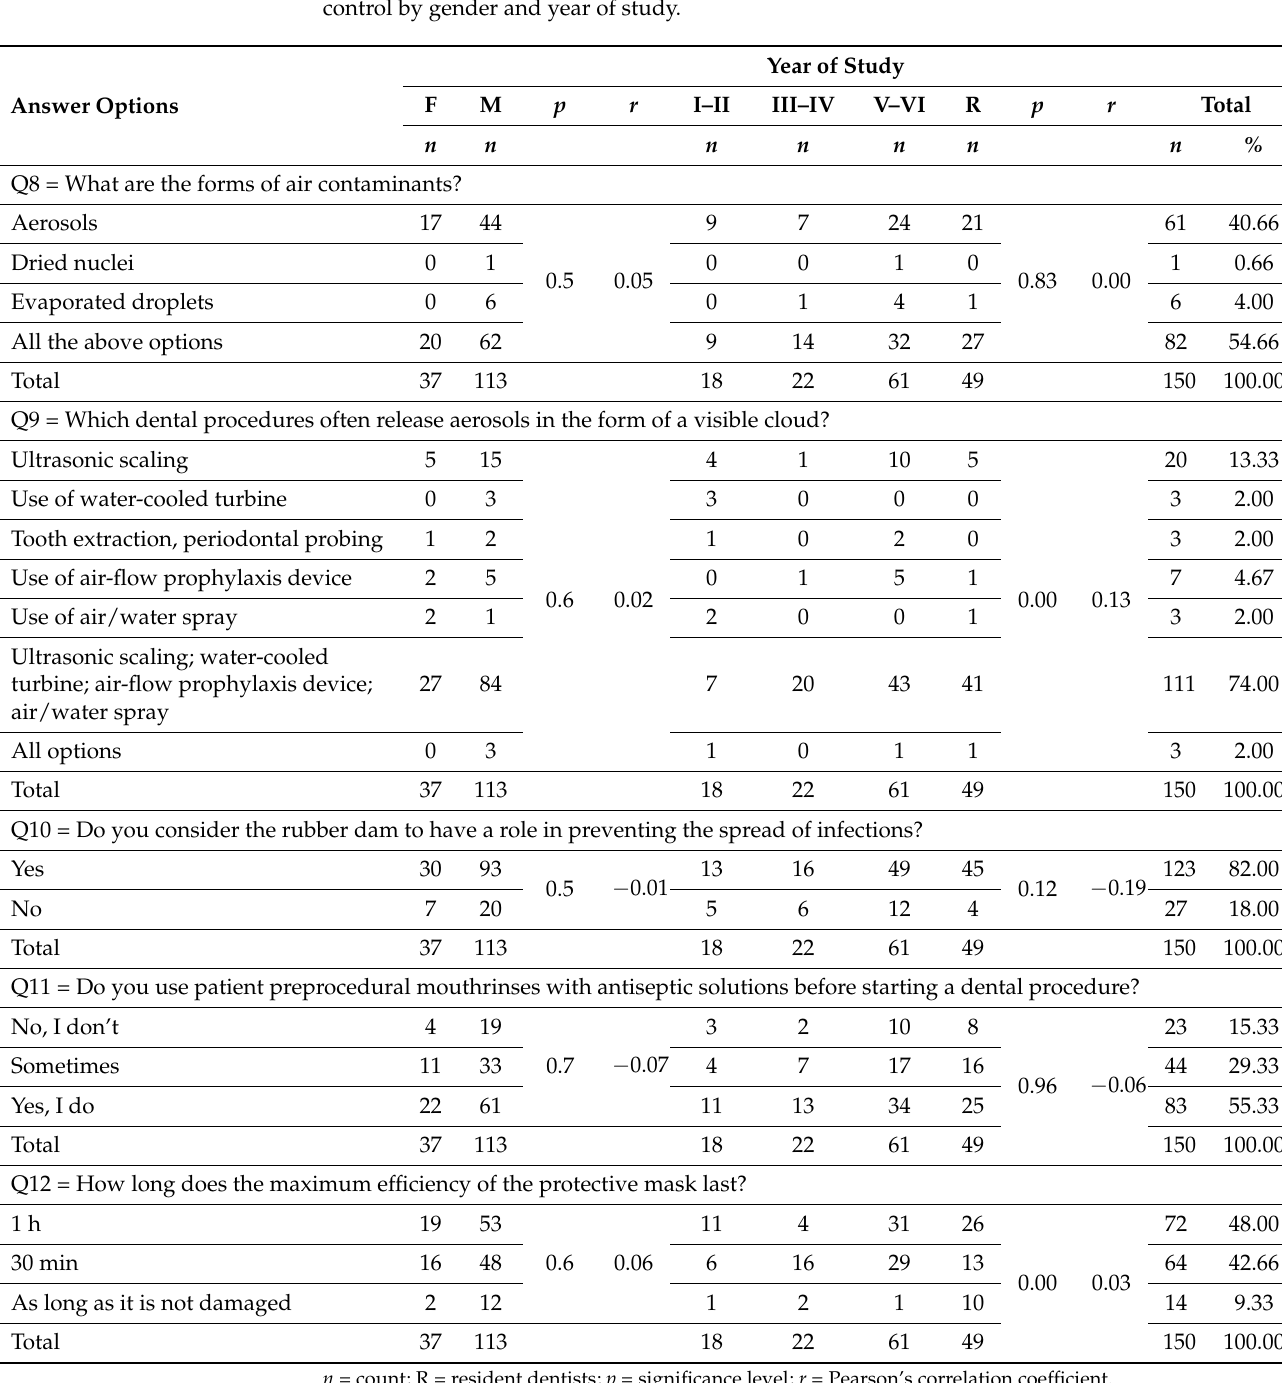
Table 4. Frequency distribution of answers to the questions about air contaminants and infection control by gender and year of